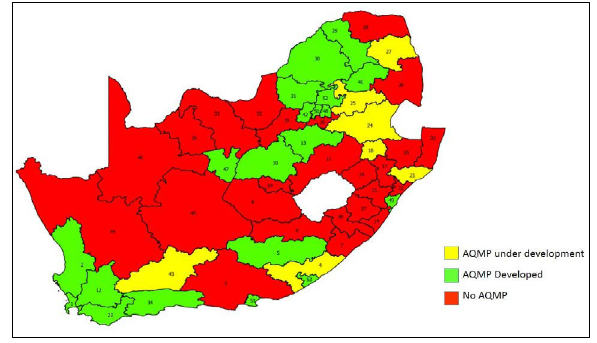
Figure 1: Current development status of district municipality Air Quality Management Development Plans in South Africa.